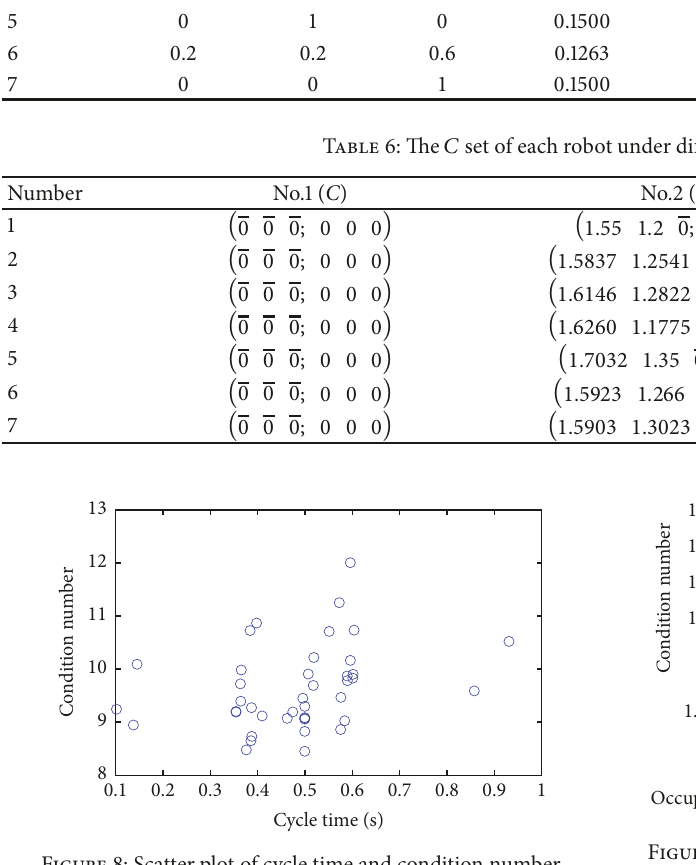
Figure 8: Scatter plot of cycle time and condition number.